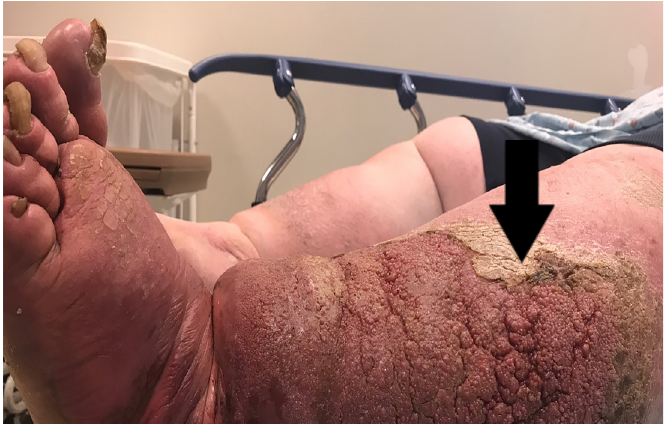
lichenfication of the skin (arrow) and